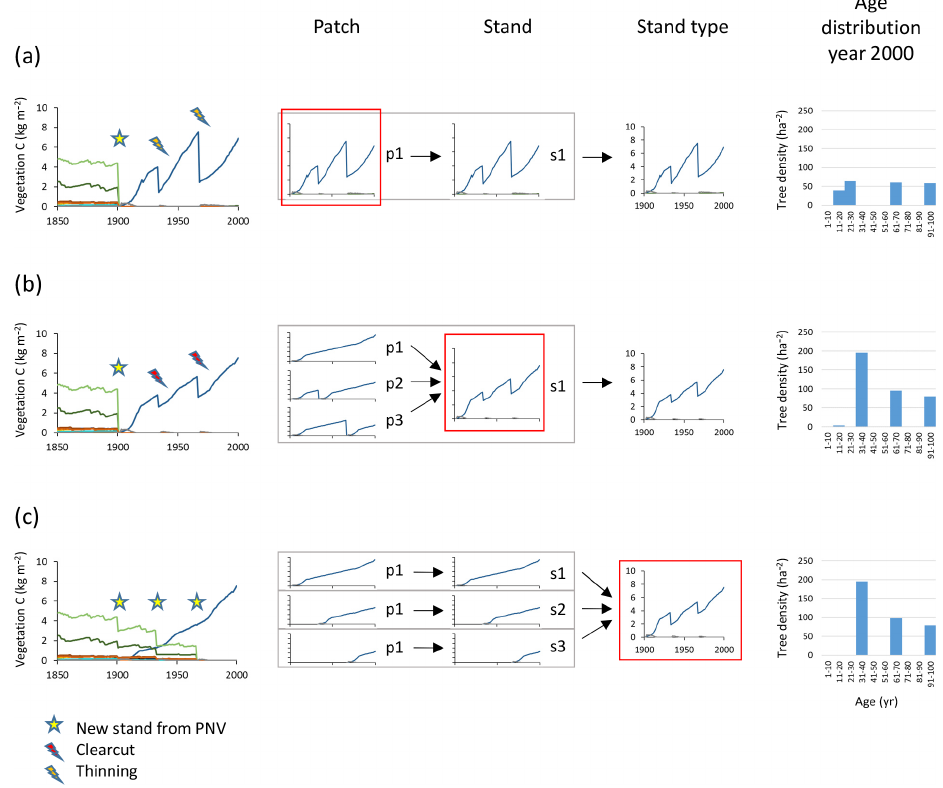
Figure 3. Examples of age structure setup at three different structural levels, patch, stand, and stand type. Monocultures of European beech are created from clear-cutting of PNV. The target in the year 2000 was three cohorts of 100, 67, and 33 years. (a) Within-patch setup with the following characteristics: one secondary stand with one patch created in 1901, thinnings in 1933 and 1967, and an age structure that depends on timing of increased light and subsequent re-establishment of seedlings. (b) Among-patch age setup with the following characteristics: one secondary stand with three patches created in 1901 and clear-cutting in patches 2 and 3 in 1933 and 1967 (evenly spread age distribution). (c) Among-stand age setup with the following characteristics: three secondary stands with one patch created in 1901, 1933, and 1967; age structure from area fraction input. Location, climate input, and species in PNV are as in Fig.